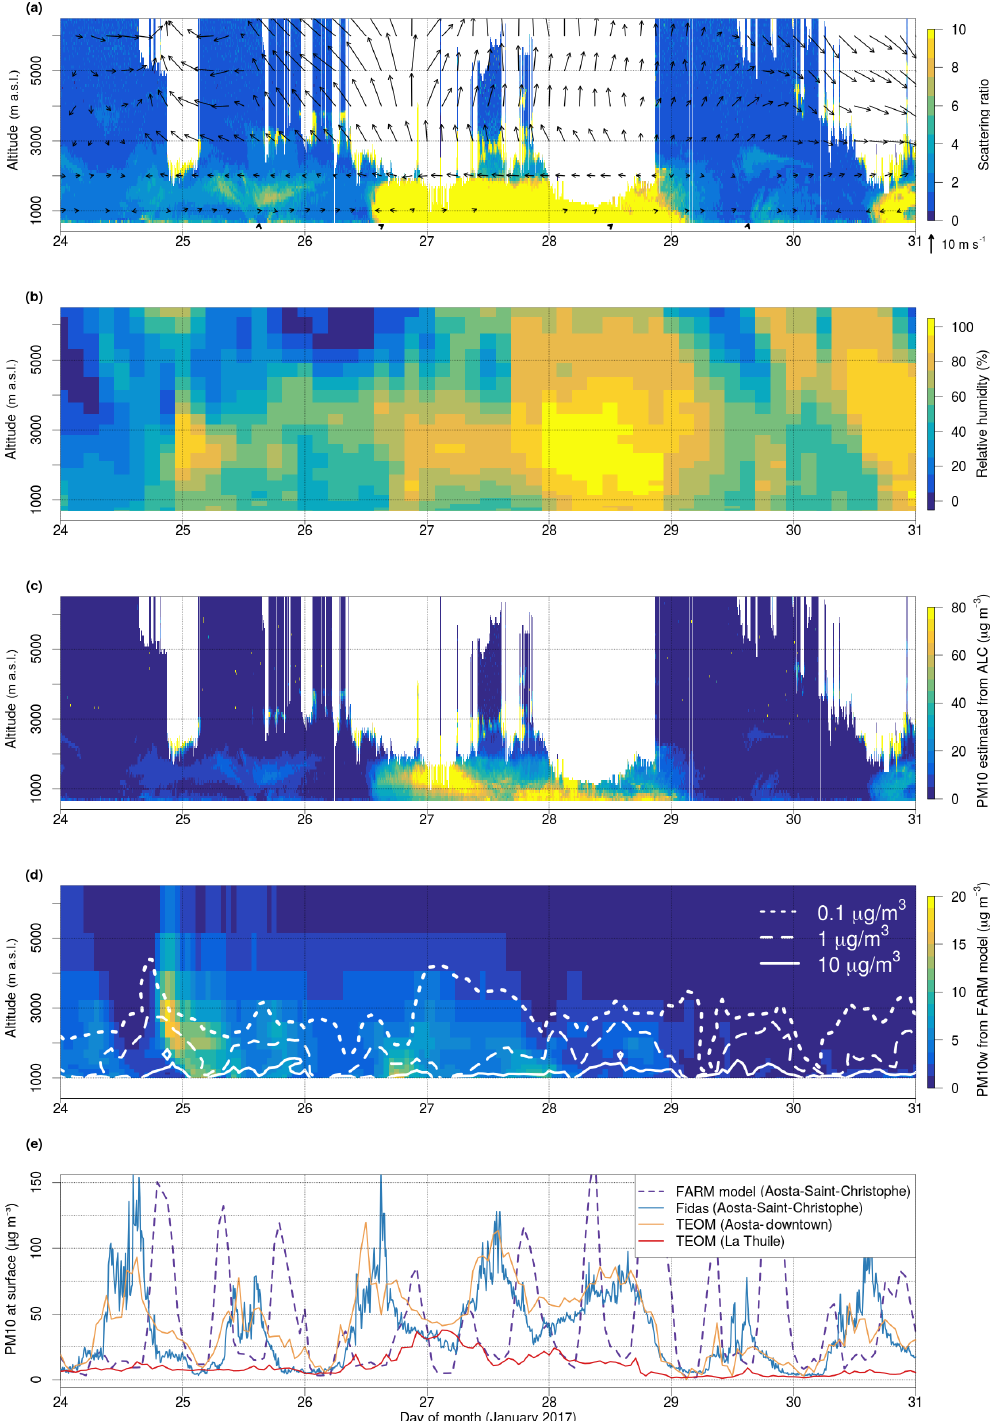
Figure 9. Case study of 24–30 January 2017. (a) Coloured background: vertical profile of scattering ratio from ALC in Aosta–Saint- Christophe. Arrows: horizontal velocity of the wind measured at the surface and simulated by COSMO at several elevations. (b) Vertical profile of relative humidity forecasted by COSMO. (c) Vertical profile of PM 10 mass concentration derived from the ALC using the functional relationships. (d) Mass concentration (PM 10w ) from FARM. (e) Hourly and sub-hourly PM 10 (dry) surface concentration from FARM simulations and observations in Aosta–Saint-Christophe, Aosta–downtown, and La Thuile (the y scale of this panel is extended compared to Figs. 3 and